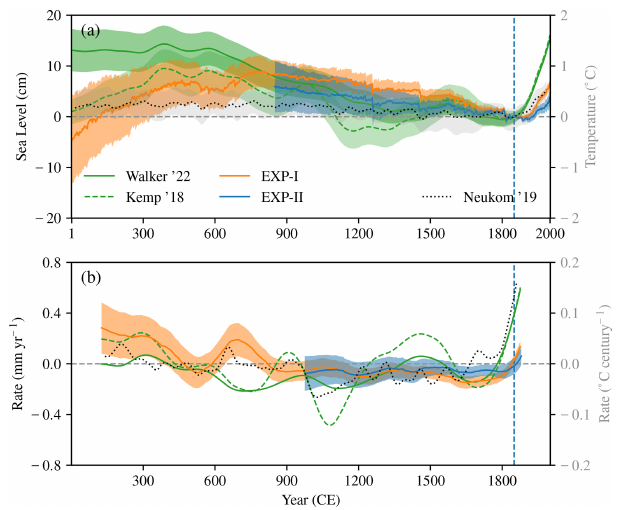
Figure 4. (a) Ensemble mean GMSL estimated as the sum of the contributing processes from EXP-I (orange) and EXP-II (blue). Proxy-based GMSL reconstruction from Walker et al. (2022; solid green), Kemp et al. (2018; dashed green), and the global-mean sur- face temperature from Neukom et al. (2019a; dotted grey) are also shown. (b) The 250-year moving rate of GMSL and global-mean surface temperature curves shown in (a) . Shading in (a) and (b) in- dicates 1 σ confidence level of the ensemble mean curve except for global-mean surface temperature (a) , for which the 95% confidence level is